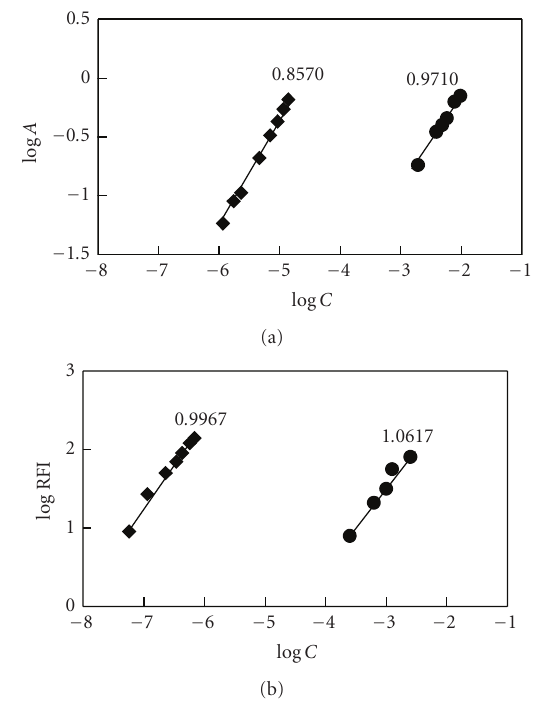
Figure 7: Limiting logarithmic plots for molar reactivity of FLX with NQS (a) and NBD-Cl (b). C, A, and RFI are the concentration, absorbance, and relative fluorescence intensity,